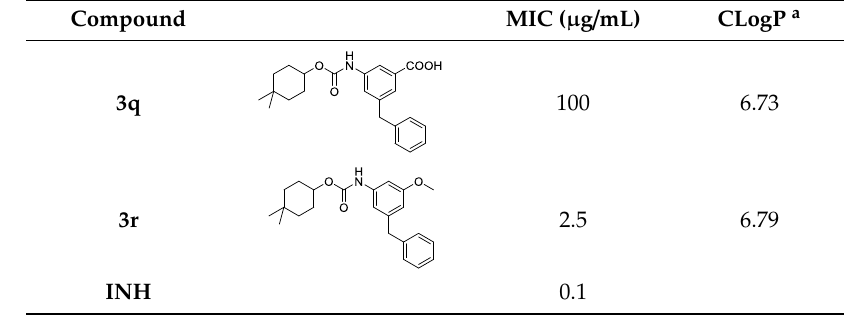
Table 3. In vitro inhibitory activity of 3q – 3r against Mtb H37Ra.